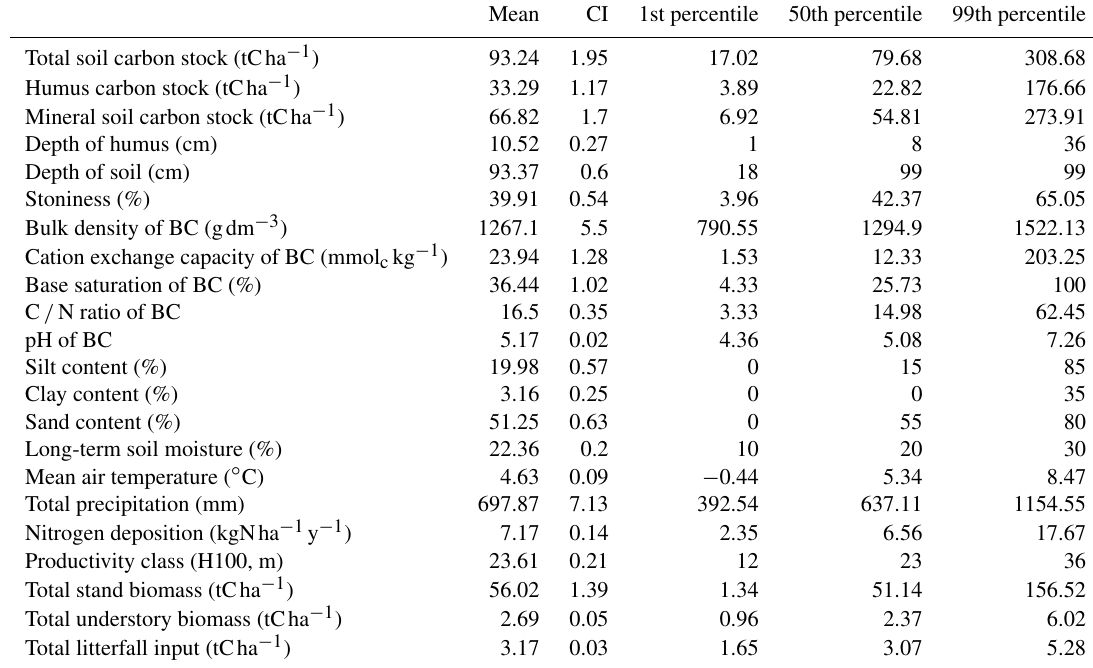
Table 2. Descriptive characteristics (mean, confidence interval, 1st, 50th, and 99th percentile) of selected variables ( n = 3230 samples). The values of the bulk density, cation exchange capacity, base saturation, C / N ratio, and pH are shown only for BC soil horizon (fixed 45–50cm depth below the ground surface) due to the strong correlation to the total soil carbon stock. The soil was cut off at 1m. The site productivity index (H100, m) is an approximation of the site fertility expressed as the height of trees at 100 years of age. Stand and understory biomass, and litter input are modeled values for approximated equilibrium conditions based on